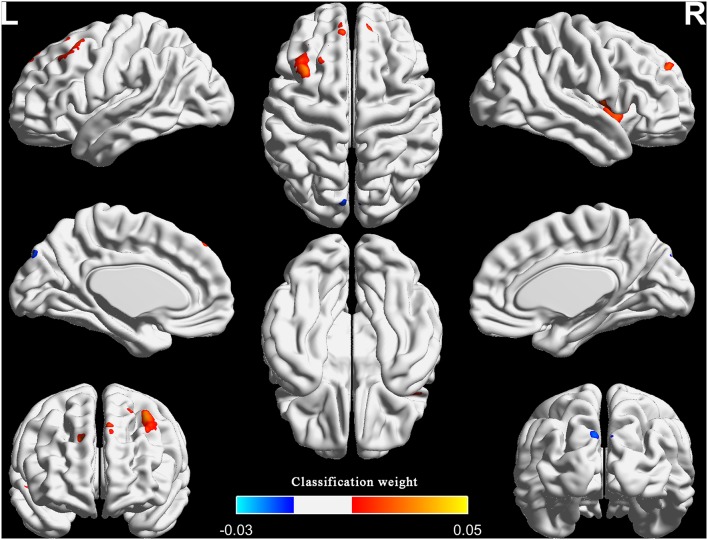
The top one percent of classification weight maps from the linear SVM classifier using the FCS as feature (cluster size threshold = 100). FCS, functional connectivity strength.